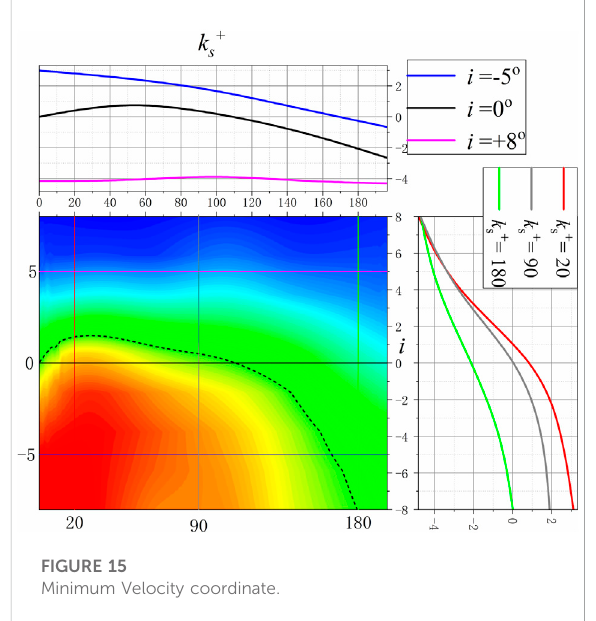
FIGURE 15 Minimum Velocity coordinate.